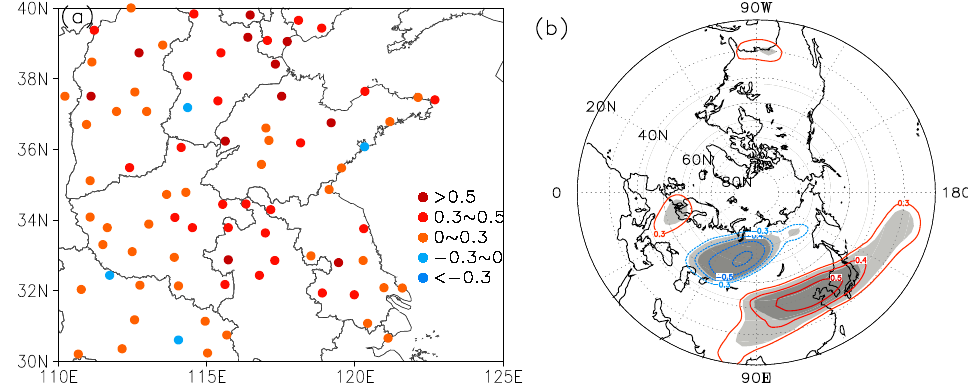
Figure 4. The heterocorrelation of the first mode of the SVD between the number of haze-fog days ( a ) and the 500 hPa geopotential height ( b ) in January from 1980 to 2015 (the shaded area denotes that the 99% confidence level is exceeded).